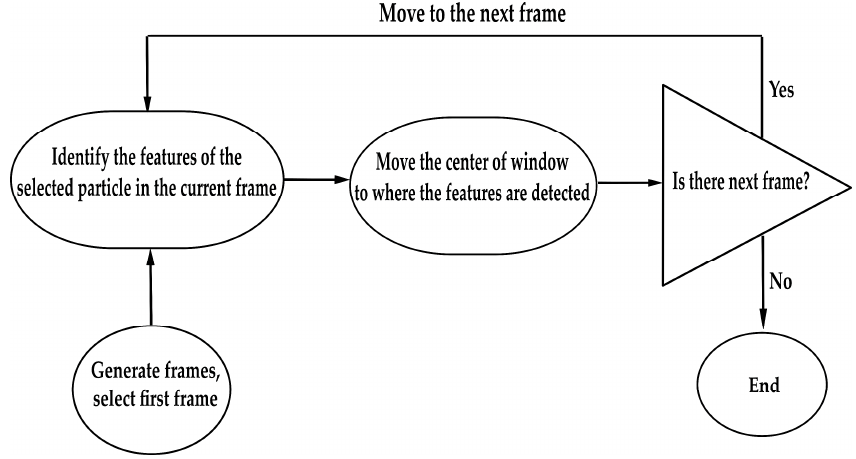
Figure 3. Flowchart describing the method for nanoparticle tracking using MATLAB software.